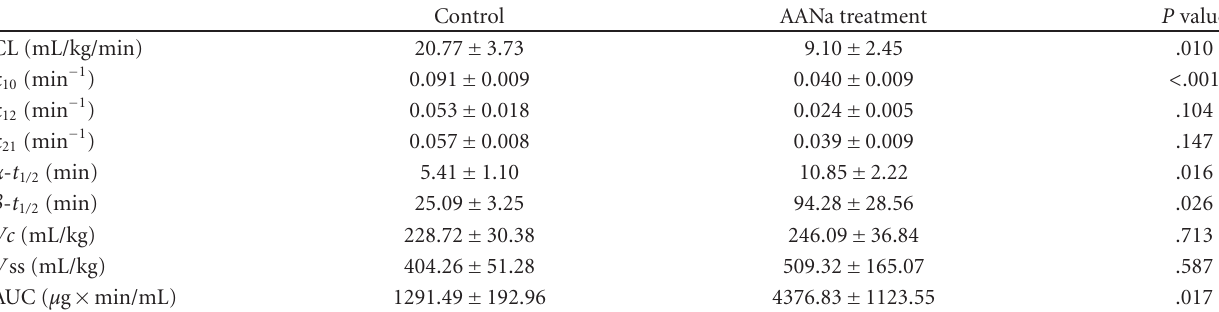
Table 1: E ff ects of 0.5 mg/kg aristolochic acid sodium (AANa) treatment on p -aminohippuric acid in rabbits ( n = 10).